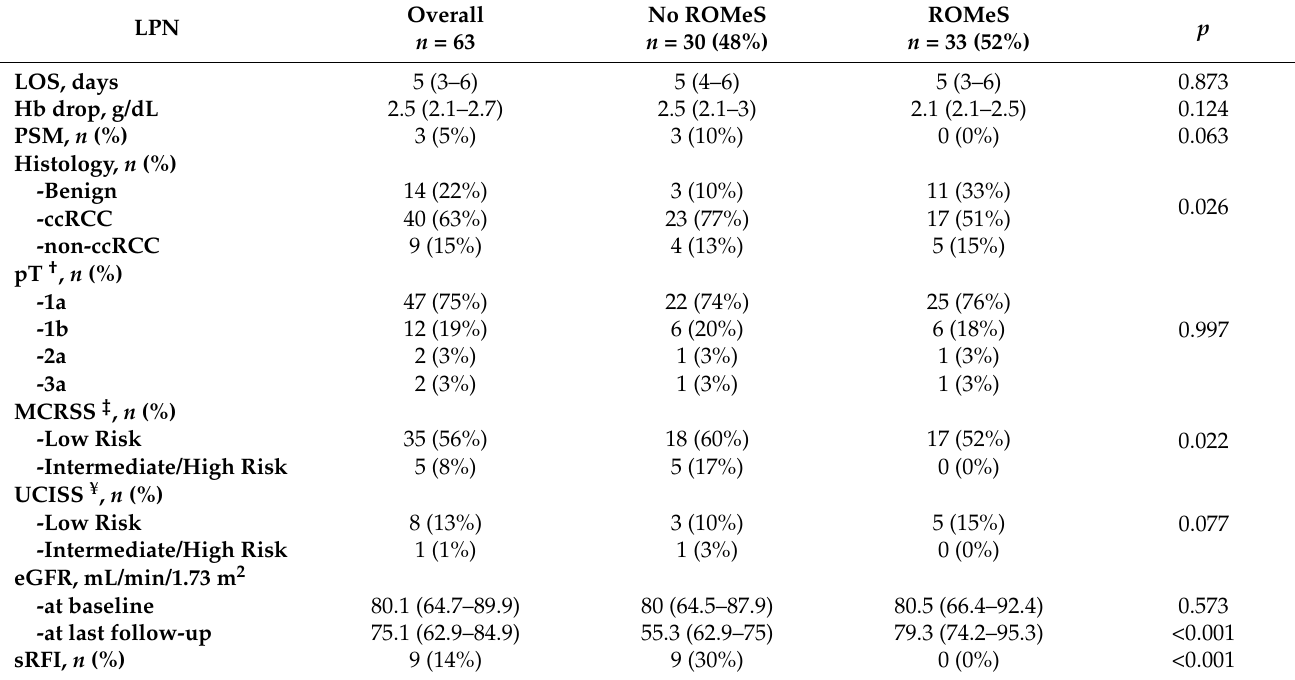
Table 2. Outcomes of LPN.